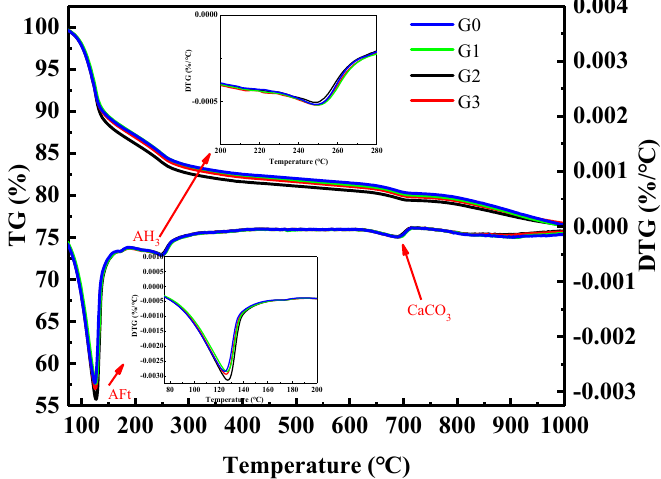
Figure 10. TG − DTG analysis of sulfoaluminate cement paste.